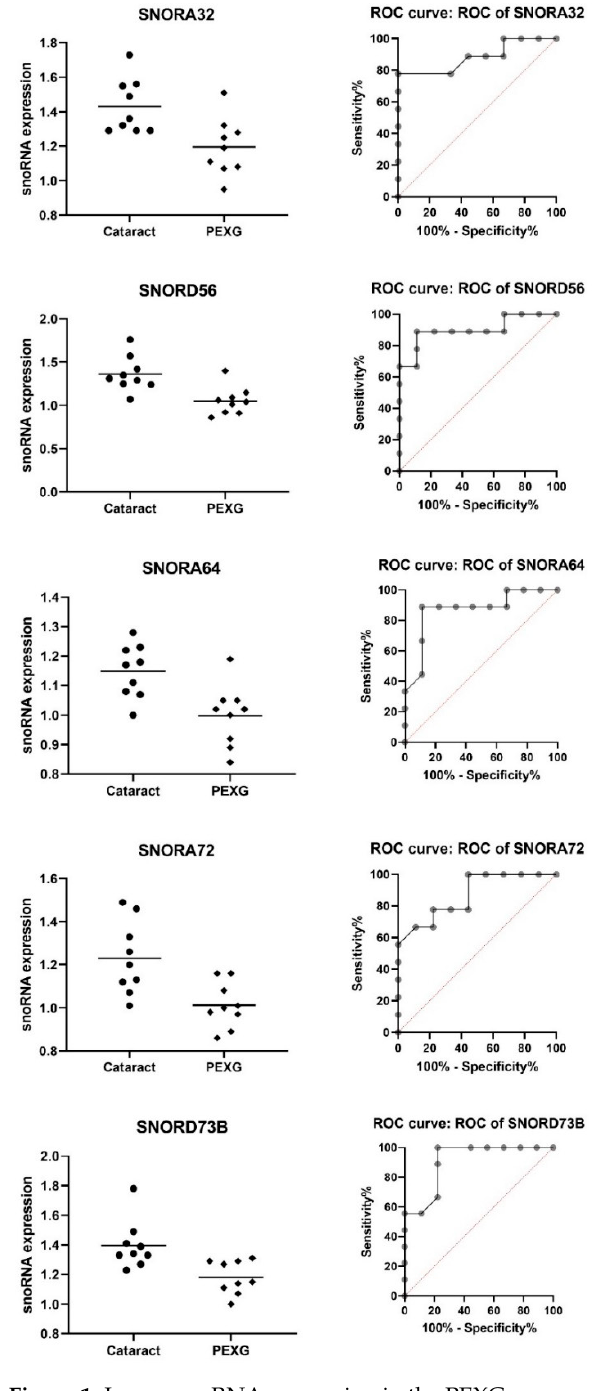
Figure 1. Lower snoRNA expression in the PEXG group compared to the cataract group. Data are shown as mean [log2].